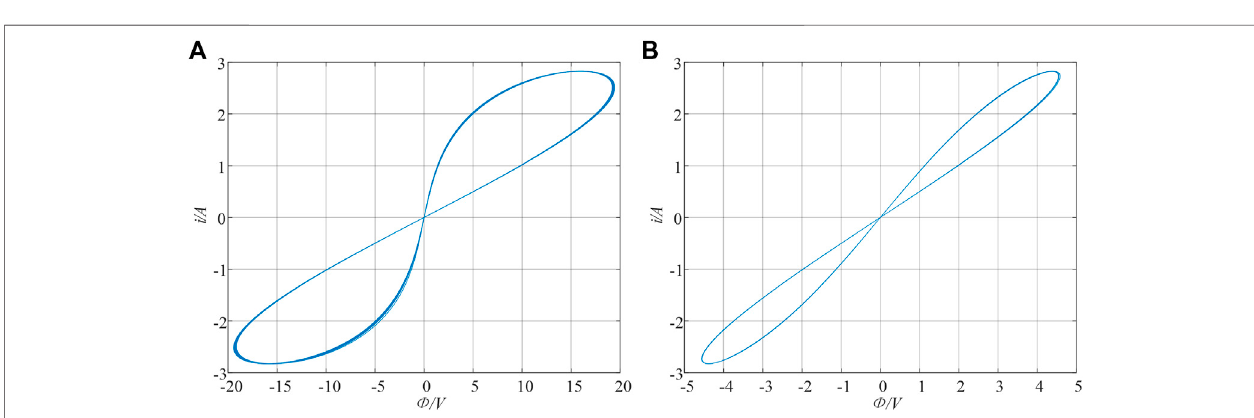
FIGURE 3 | Hysteresis curve of the meminductor, (A) e = 1, g = 1, f = 5 Hz. (B) e = 1, g = 1, f = 20 Hz.